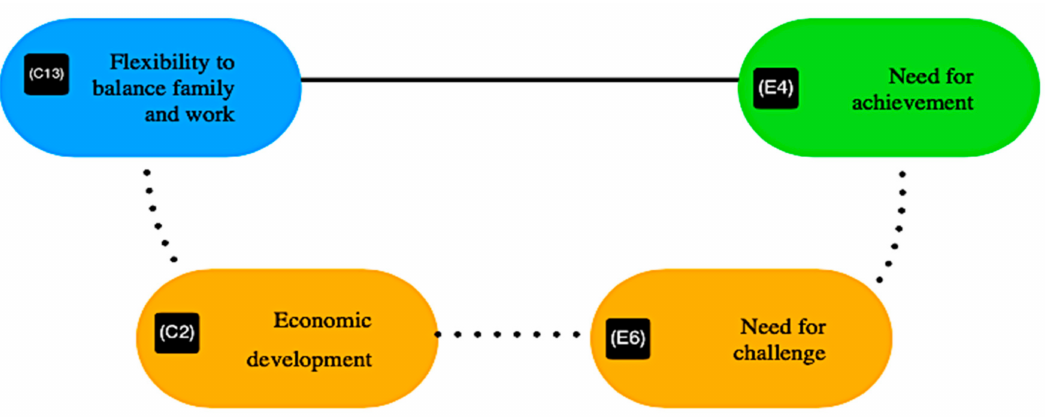
Figure 8. Flexibility to balance family and work and need for achievement. Incidence C 13 → E 4 . Source: Authors’ elaboration based on Fuzzy